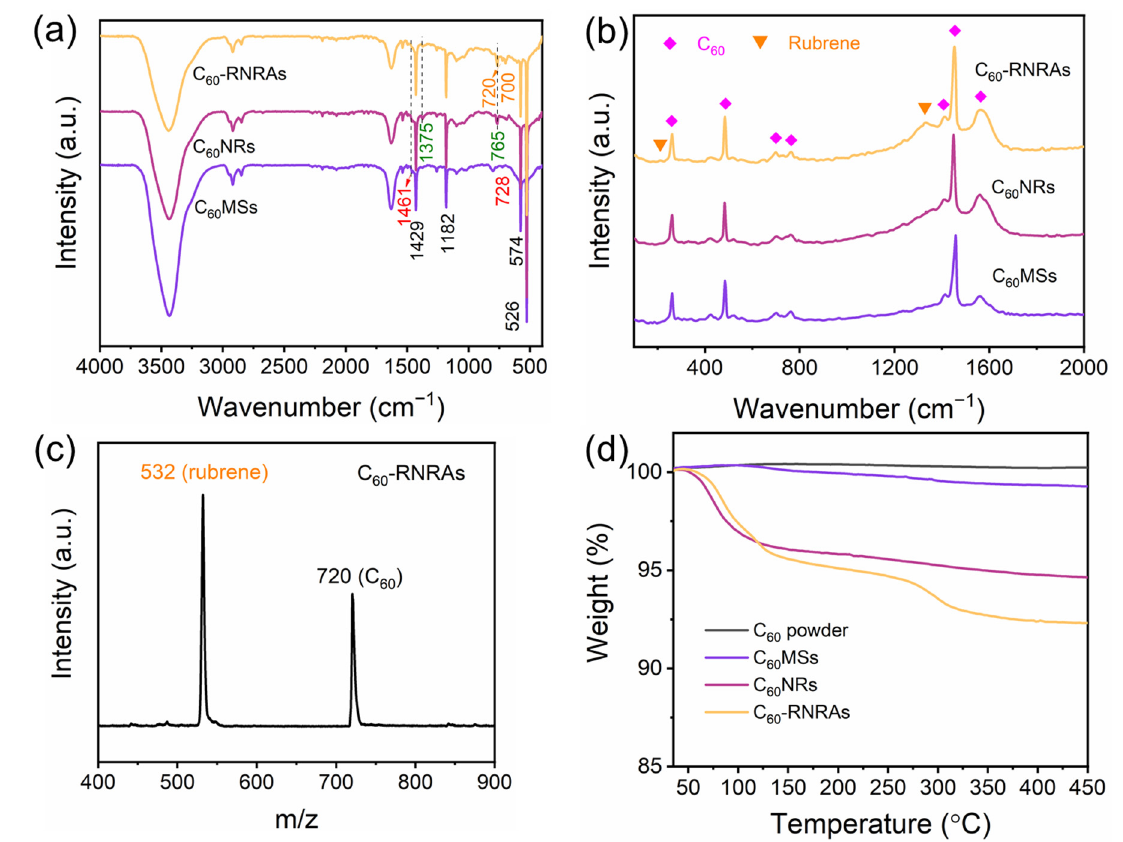
Figure 4. ( a ) FT-IR and ( b ) Raman spectra of C 60 MSs , C 60 NRs , and C 60 -RNRAs , ( c ) LDI-TOF mass spectrum of C 60 -RNRAs , and ( d ) TG analysis of C 60 powder, C 60 MSs , C 60 NRs , and C 60 -RNRAs .